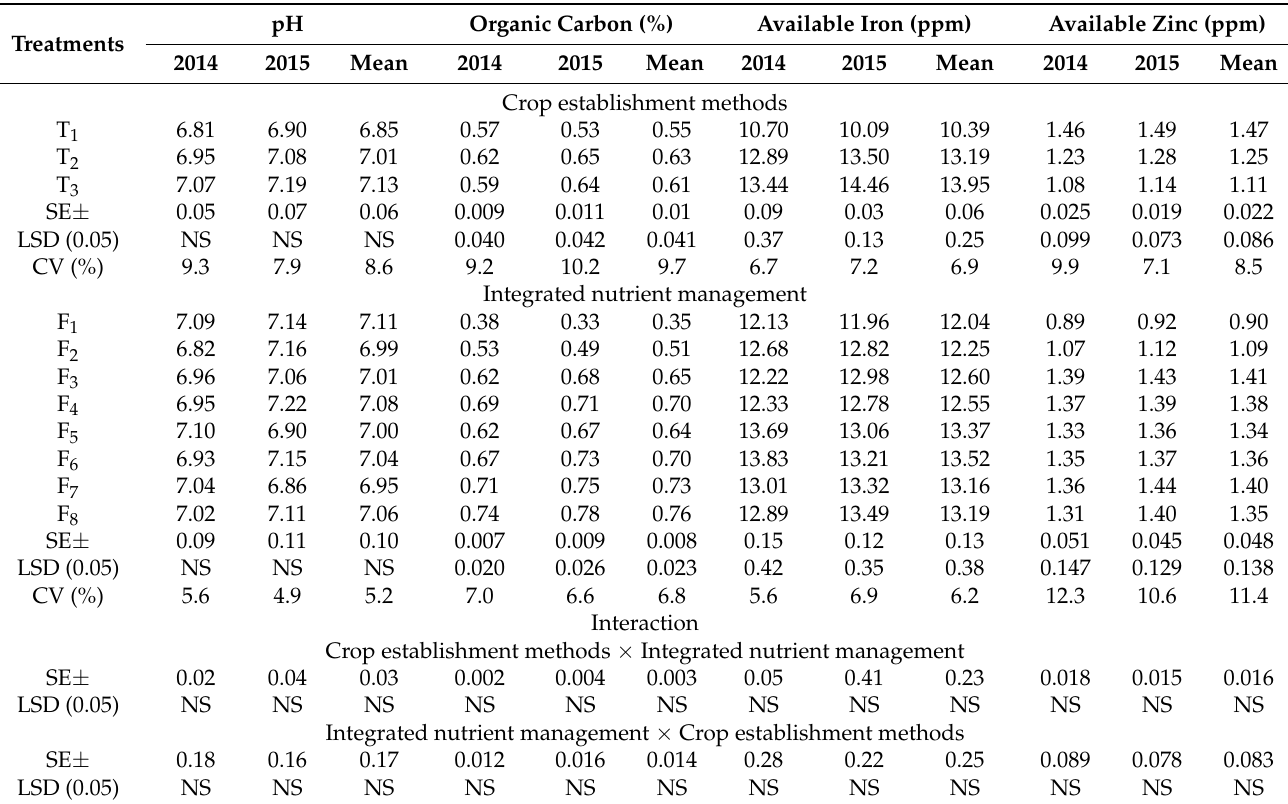
Table 6. Crop establishment methods and integrated nutrient management influence the soil pH, organic carbon, available iron, and available Zn after harvest of rice. pH Organic Carbon (%) Available Iron (ppm) Available Zinc Treatments